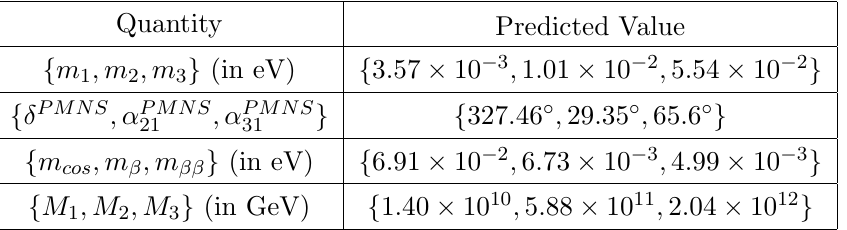
2 m m i , m (cid:12) = P U ei i is i i j j P U 2 m i is the e(cid:11)ective mass parameter ei i j j